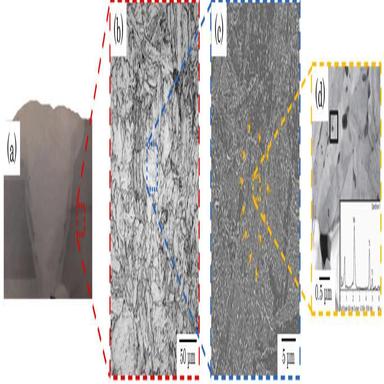
Varying orders of microstructural morphology in X100Q PM: (a) Optical micrograph of cross-section of X100Q cross-weld sample (highlighted region in PM), (b) Optical micrograph of X100Q PM, (c) SEM micrograph of X100Q PM with a grain boundary highlighted, (d) TEM micrograph of X100Q, illustrating bainitic lath substructure and lath boundary precipitates from Fang et al..